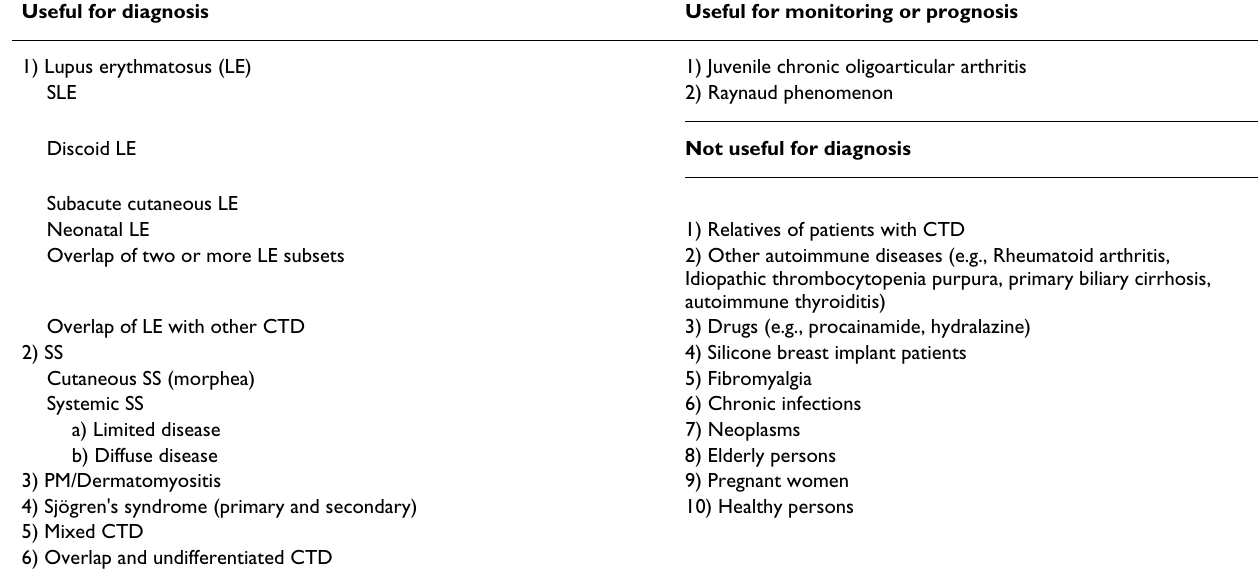
Table 2: Significance of positive ANA test in CTD and some non-autoimmune conditions [36] Useful for diagnosis Useful for monitoring or prognosis